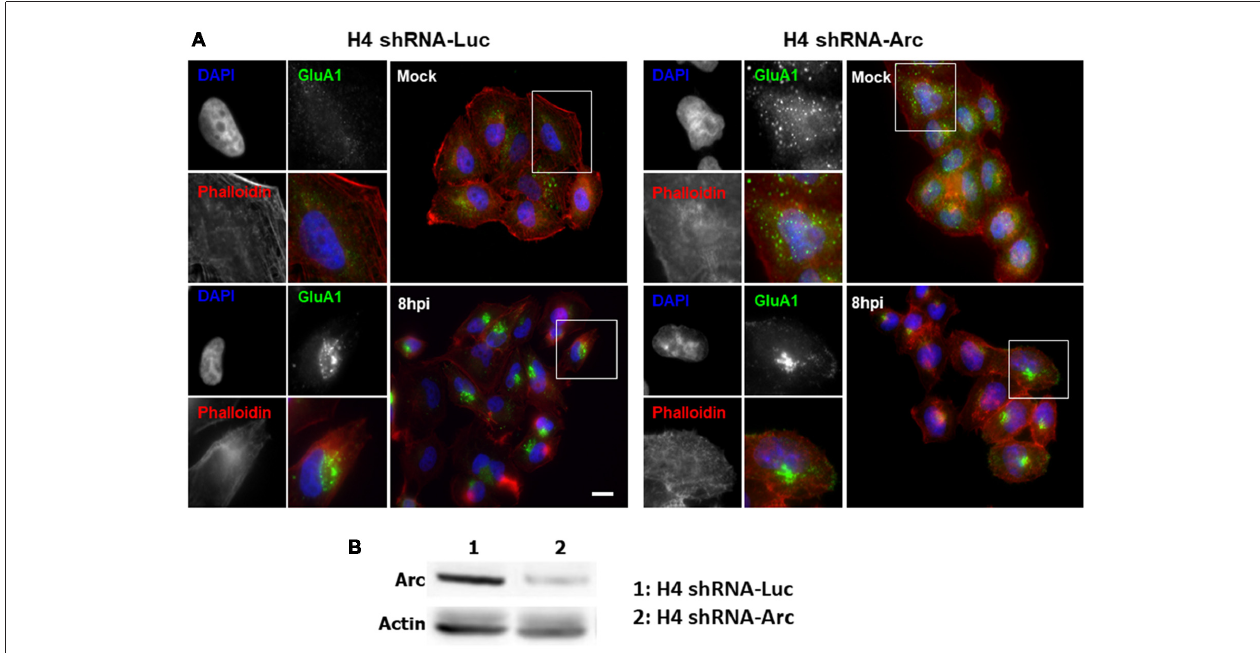
FIGURE 8 | Redistribution of AMPAR GluA1 subunit during HSV-1 infection is independent of Arc expression. (A) H4 cells stably expressing either the shRNA to luciferase (H4 shRNA-Luc) used as a control or the shRNA to Arc (H4 shRNA-Arc) to achieve silencing of Arc knockdown (KD) were infected with HSV-1 (MOI = 10) during 8 hpi. Then, GluA1 subunit and ICP8 were immunodetected with specific antibodies followed of secondary antibodies couple to Alexa Fluor 488 and 647, respectively. Phalloidin staining was coupled with Alexa Fluor 594 dye and Nuclei stained with DAPI. Scale bar corresponds to 10 µ m. Magnification 630 × . The boxes inserted show a zoom capture of the indicated areas. (B) Total protein extracts of H4 shRNA-Luc and H4 shRNA-Arc were analyzed by immunoblot with antibodies to the proteins Arc and GADPH. The results shown are representative of three independent